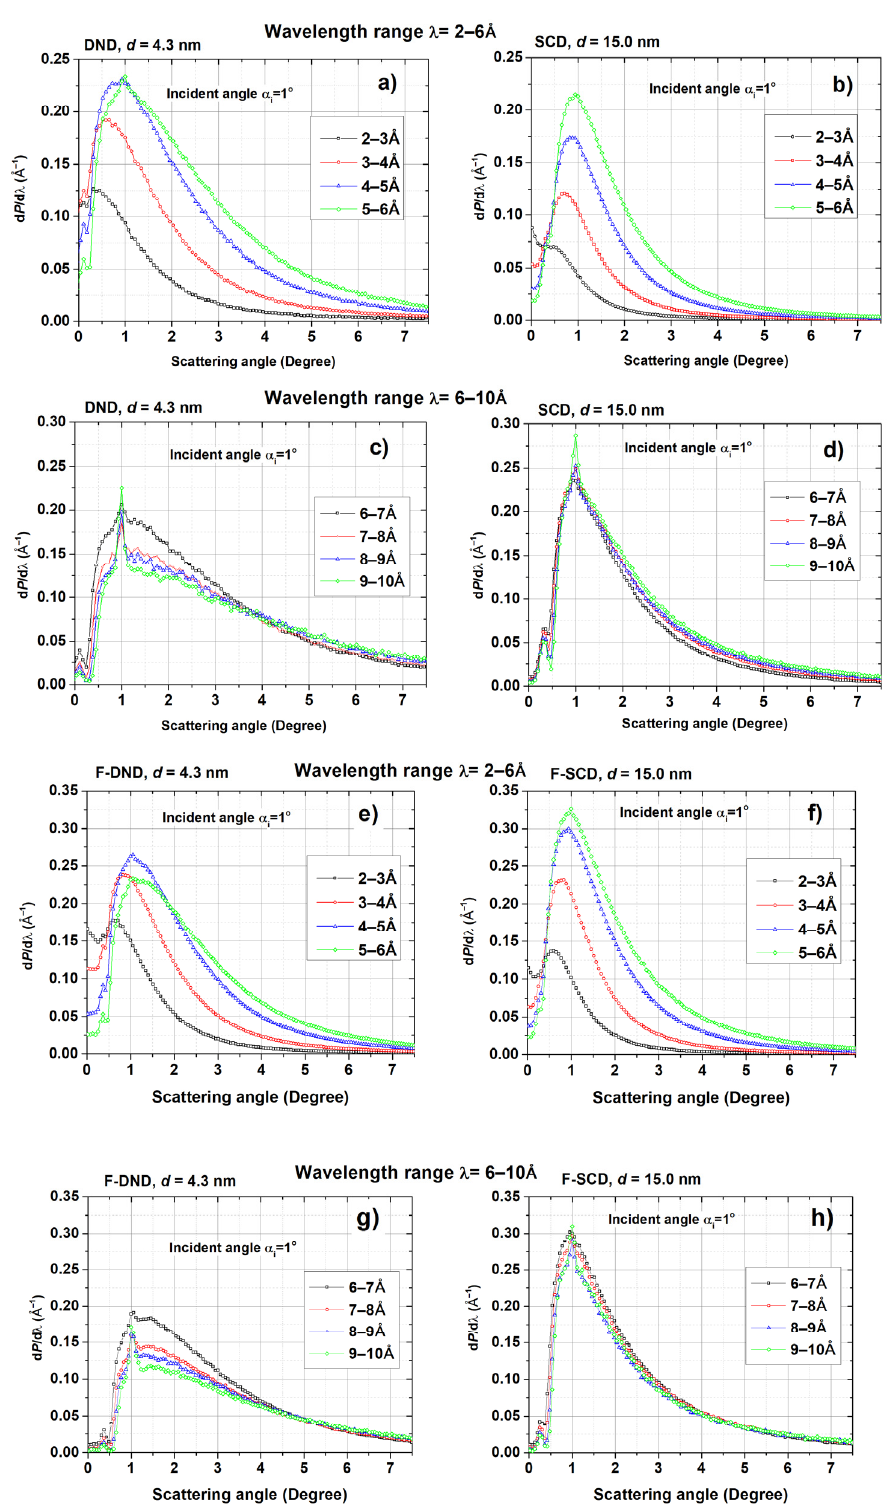
Figure 9. Differential probability of neutron scattering (vertical axis) as a function of the reflection angle (horizontal axis) within the angular acceptance of the D17 detector. Samples and wavelength ranges: ( a ) DND, 2–6 Å; ( b ) SCD, 2–6 Å; ( c ) DND, 6–10 Å; ( d ) SCD, 6–10 Å; ( e ) F-DND, 2–6 Å; ( f ) F-SCD, 2–6 Å; ( g ) F-DND, 6–10 Å; ( h ) F-SCD, 6–10 Å. For all cases, the angle of incidence was 1°.